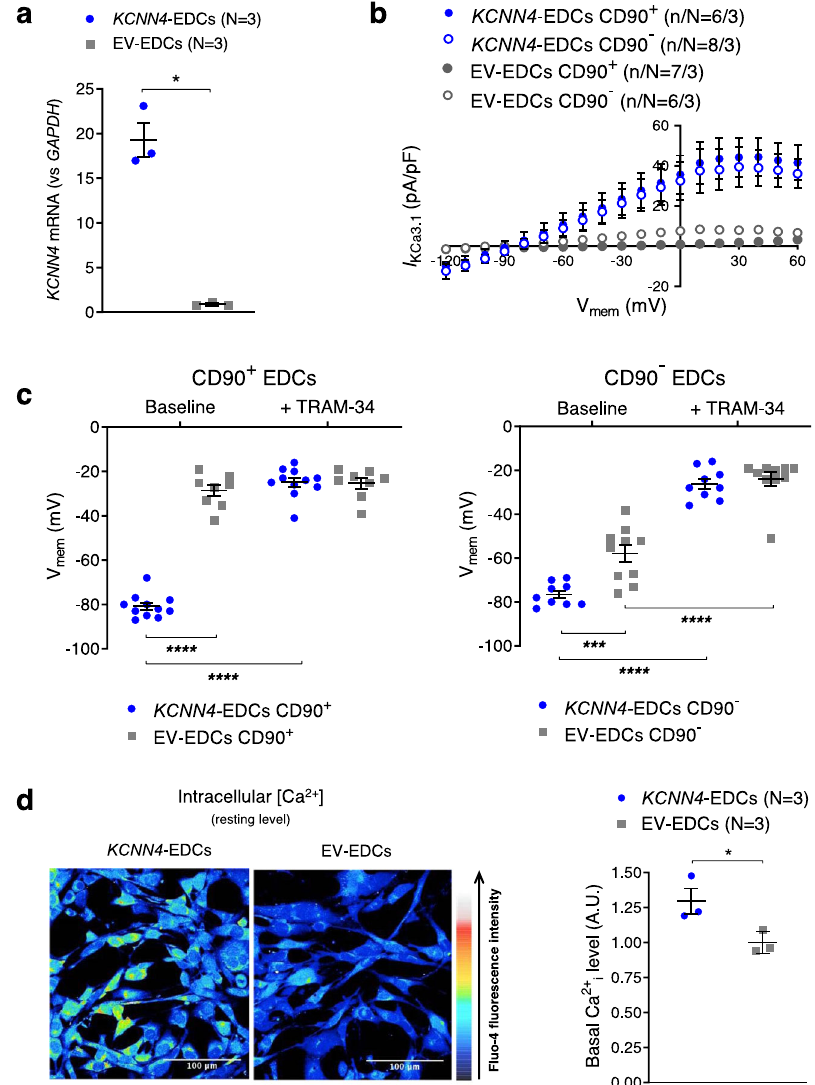
Fig. 3 Effect of KCNN4 -gene transfer on I KCa3.1 and membrane potential of EDCs. a Mean ± SEM KCNN4 -gene expression in EDCs following lentivirus- mediated KCNN4 -gene transfer or empty vector (EV; multiplicity of infection = 20). Circles = KCNN4 -transduced EDCs, squares = EV-EDCs. b I – V relationship of I KCa3.1 currents recorded under various experimental conditions. Blue symbols = KCNN4 -transduced EDCs, gray symbols = EV-EDCs. Filled symbols = CD90 + , open symbols = CD90 − . c Resting potential of EDCs under various experimental conditions, before and after exposure to 1 µ mol/L TRAM-34. Blue symbols = KCNN4 -transduced EDCs, gray symbols = EV-EDCs. d Representative Fluo-4 images in EV- and KCNN4 -transduced EDCs overexpression on intracellular [Ca 2 + ]. Data in b – d are shown as individual points, along with mean and SEM. Paired two-sided Student t -test; N = biological samples (panel a ); two-way repeated-measures ANOVA with individual-mean comparisons by Bonferroni-corrected two-sided t -tests; n/N = cells/cell lines per group (panel c ). Blue symbols = KCNN4 -transduced EDCs, gray symbols = EV-EDCs. Open circles = CD90 − , closed circles = CD90 + . EDC explant-derived cell, EV empty vector, min minutes, V mem membrane potential. * P < 0.05, *** P < 0.001, **** P < 0.0001. For precise P values, see Supplemental Source Data and Statistics fi